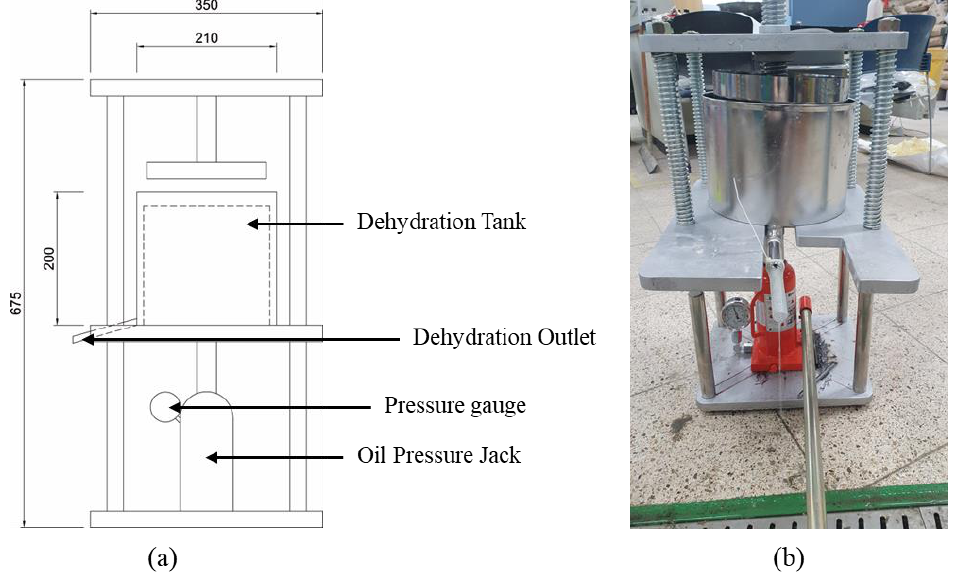
Figure 2. Pressurized dehydration equipment: ( a ) conceptual diagram and ( b ) installation example.